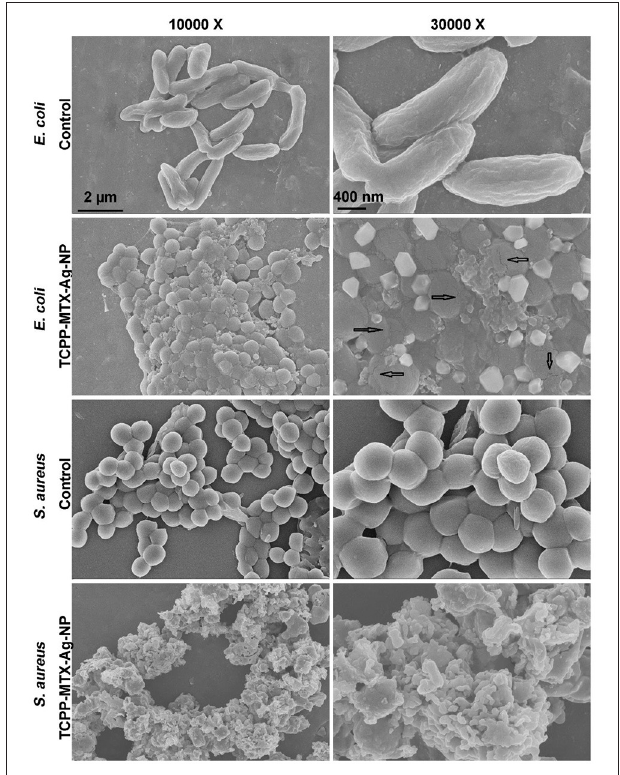
FIGURE 5 | The SEM images of the E. coli and S. aureus, the arrow indicates membrane rupture (the left scale bar represents 2 µ m, the right scale bar represents